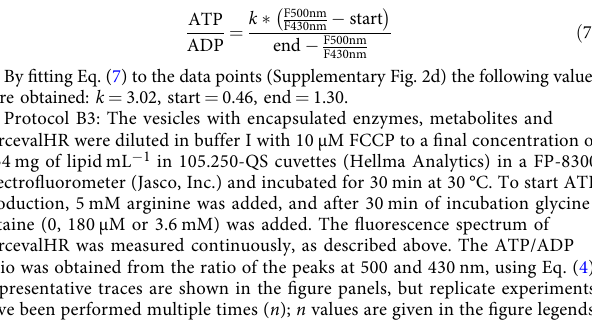
Protocol B3: The vesicles with encapsulated enzymes, metabolites and PercevalHR were diluted in buffer I with 10 µM FCCP to a fi nal concentration of